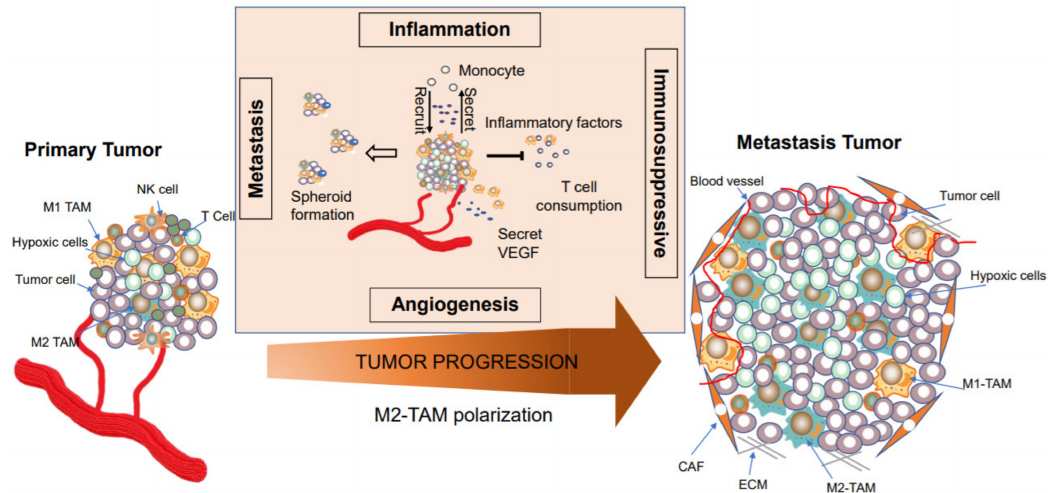
Figure 3. Co-evolution of cancer cells and TAMs in tumor progression. The early stage of the primary tumor exhibits more M1-like TAMs, T cells, and NK cells. Along with disease progression, tumor cells promote M2-TAM polarization and utilize M2-like TAMs to inhibit effector T cell or NK cell infiltration. Moreover, TAMs promote tumor spheroid formation and facilitates peritoneal metastasis. The polarized M2-like TAMs create the immunosuppressive micro-environment for facilitating metastatic tumor progression by secreting cytokines, such as VEGF, to induce angiogenesis, releasing inflammatory factors to recruit circulating monocytes to tumor mass, utilizing amino acids like arginine to inhibit T cells function, and promoting tumor spheroid formation to facilitate tumor